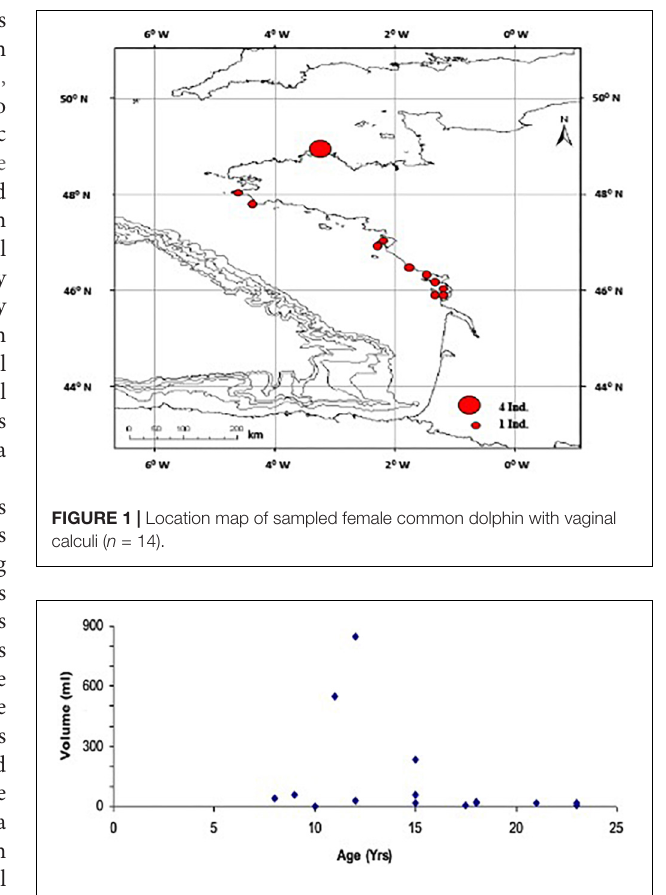
FIGURE 2 | Vaginal calculus size as a function of dolphin age ( n = 14).